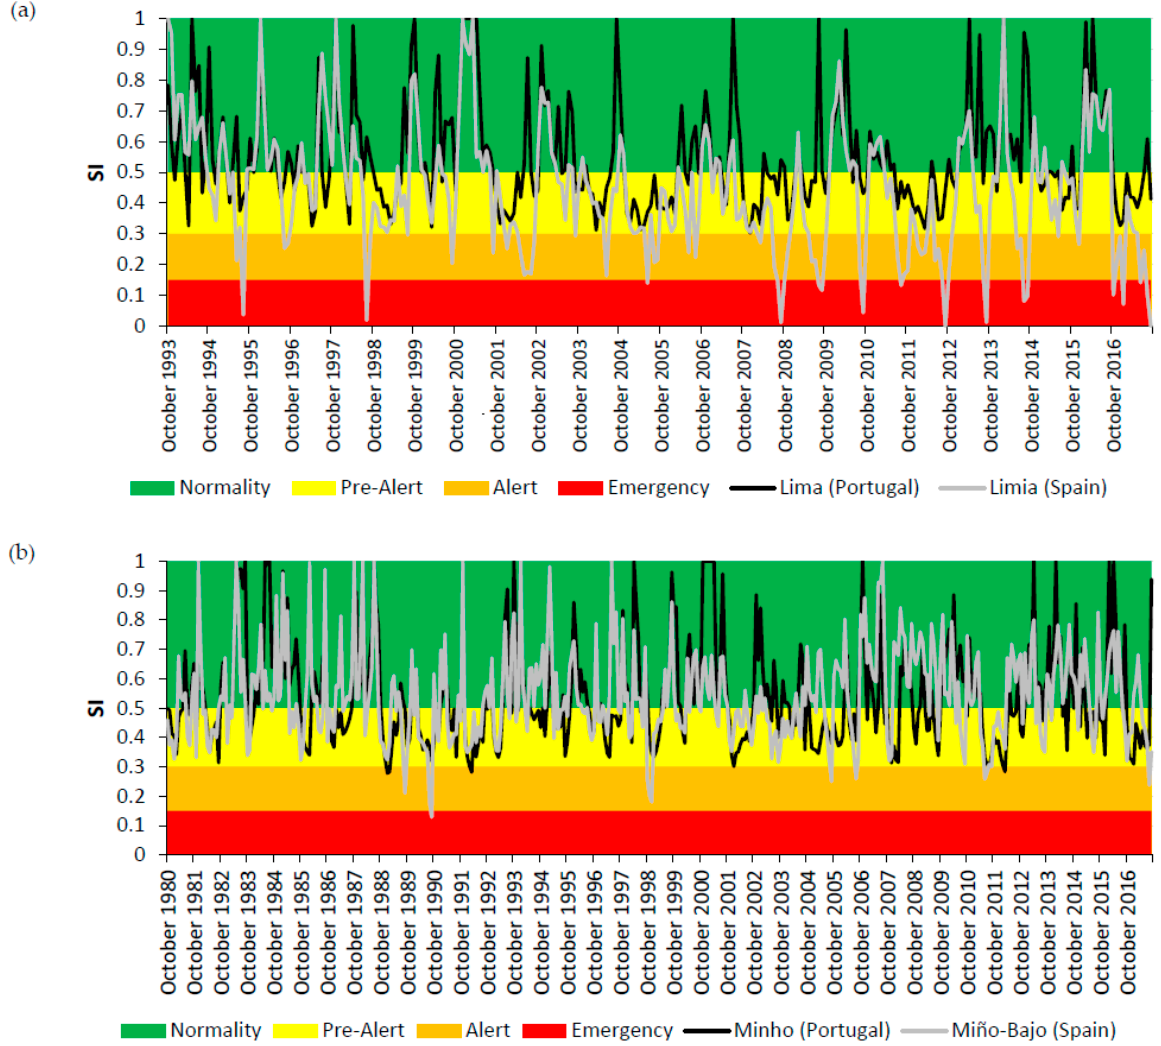
Figure 7. Scarcity Indicator (SI) in ( a ) the Portuguese part (Lima) and the Spanish part (Limia) of the Lima river basin for the period October 1993–September 2017; and in ( b ) the Portuguese part (Minho) and the Spanish part (Miño-Bajo) of the Minho river basin for the period October 1980–September 2017. Table 2. Distribution of the scarcity status in the Portuguese and Spanish parts of the Lima and Minho river